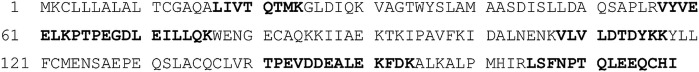
Amino acid sequence for β-Lg from Bos taurus (gi/229460).The tryptic peptides obtained for 24 kDa protein from buffalo cheese way were identical to the red sequence. It was obtained 37% of coverage.